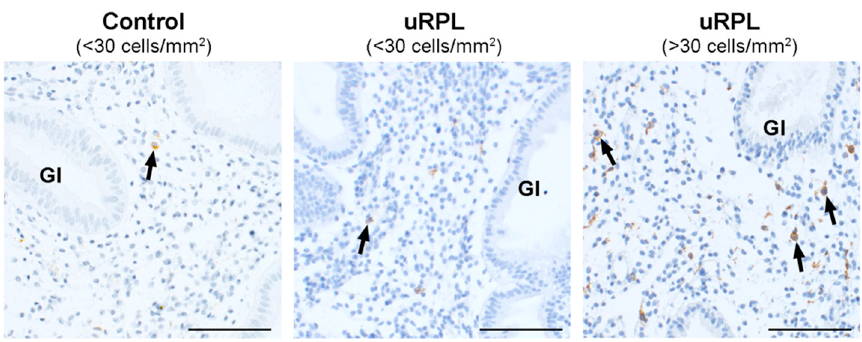
Figure 3. Immunohistochemical localization of CD16 + cells (arrows) in the endometrium of control ( < 30 cells / mm 2 ) and uRPL cases ( < 30 and > 30 cells / mm 2 ). Gl: endometrial glands. Scale bar = 100 µ m.